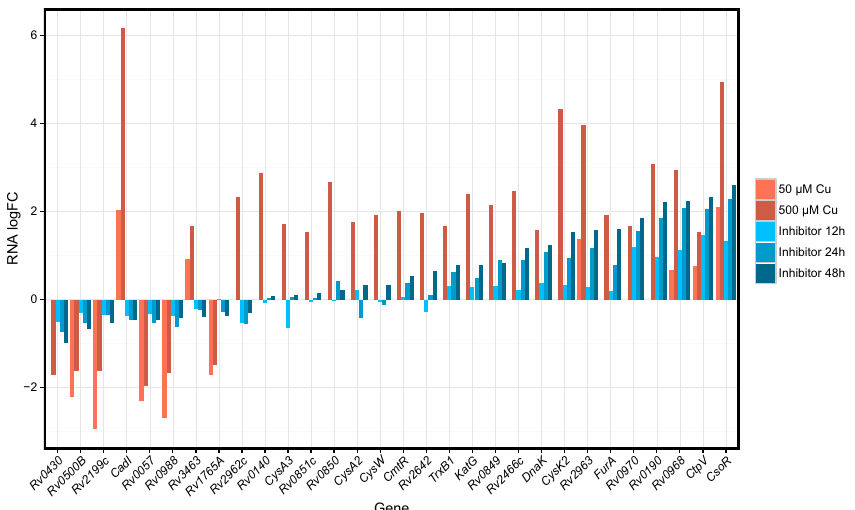
Fig. 2 The transcriptional response of the CsoR regulon to PknA/PknB inhibition mirrors that of copper exposure. Log2 fold changes in RNA for genes in the CsoR regulon after treatment with the PknA/PknB inhibitor are shown in blue, changes in RNA after treatment with copper are shown in red (copper data from 15 ). The copper-sensitive operon repressor (CsoR) showed the greatest change in phosphorylation and increase in TF node strength upon PknA/PknB inhibition (Fig. 3).